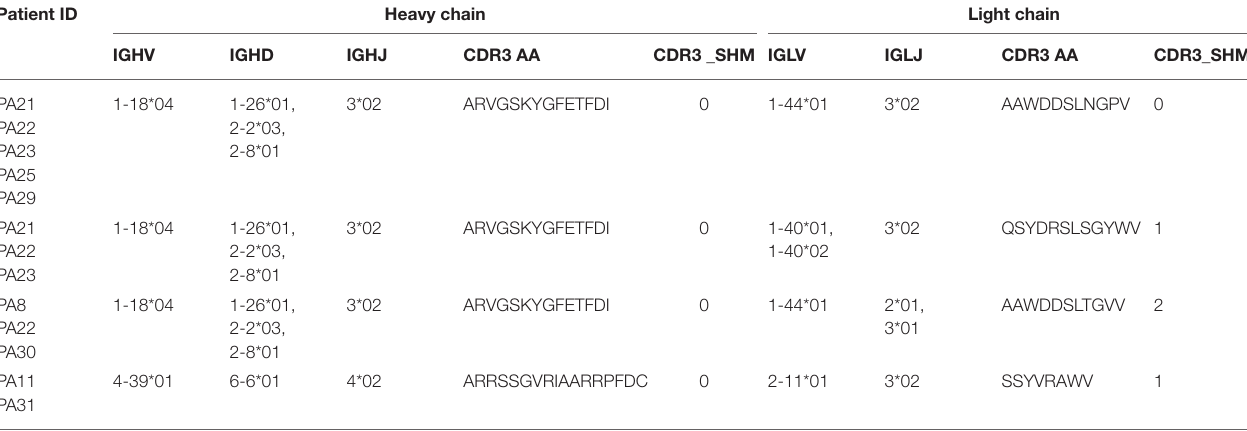
TABLE 2 | Shared clonotypes among patients with anti-NMDAR encephalitis. Patient ID Heavy chain Light chain